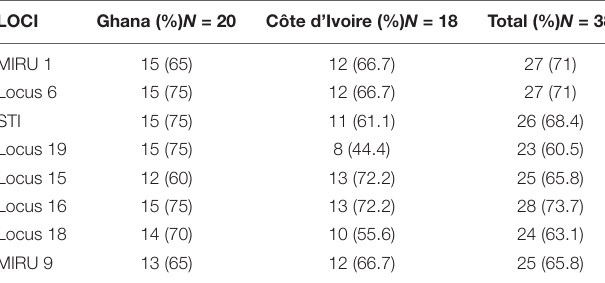
TABLE 3B | Frequency distribution of successful amplification at the different loci for the environmental samples. LOCI Ghana (%) N = 20 Côte d’Ivoire (%) N = 18 Total (%) N = 38